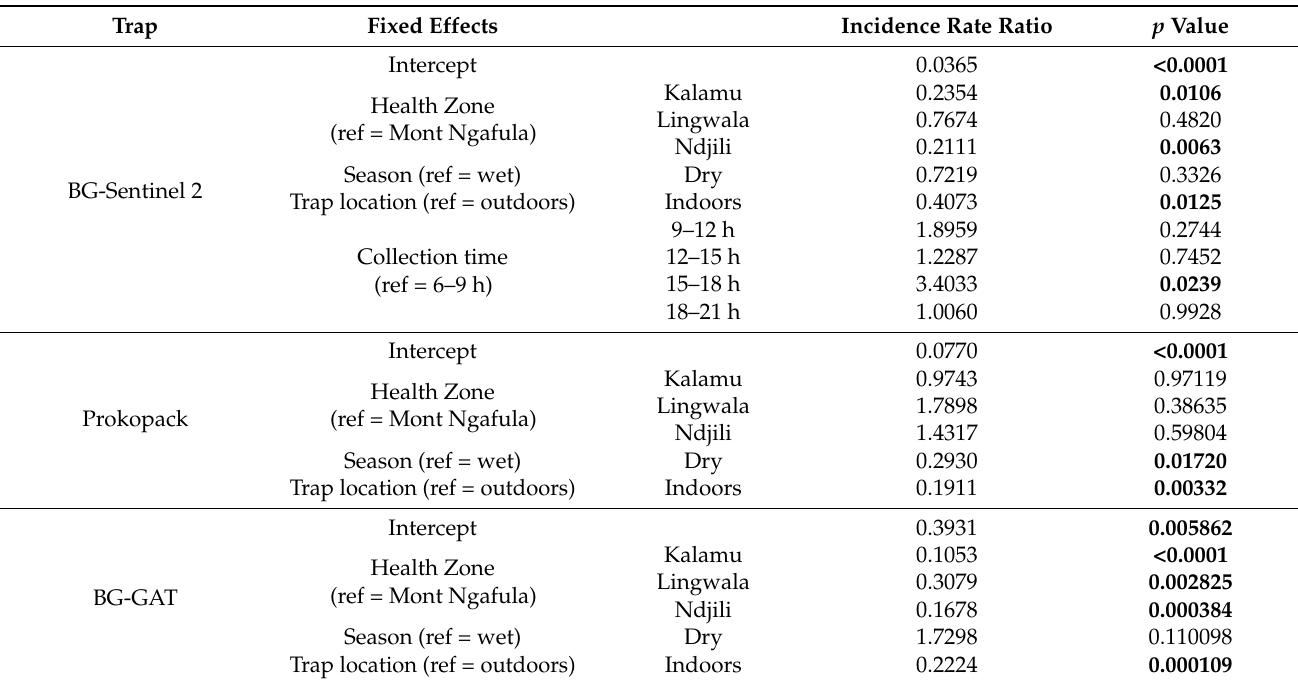
Table 3. The effects of commune, season (survey), time of collection, and place of collection on the collection of female Aedes albopictus based on a GLM with negative binomial distribution. p Values lower than 0.05 are highlighted in